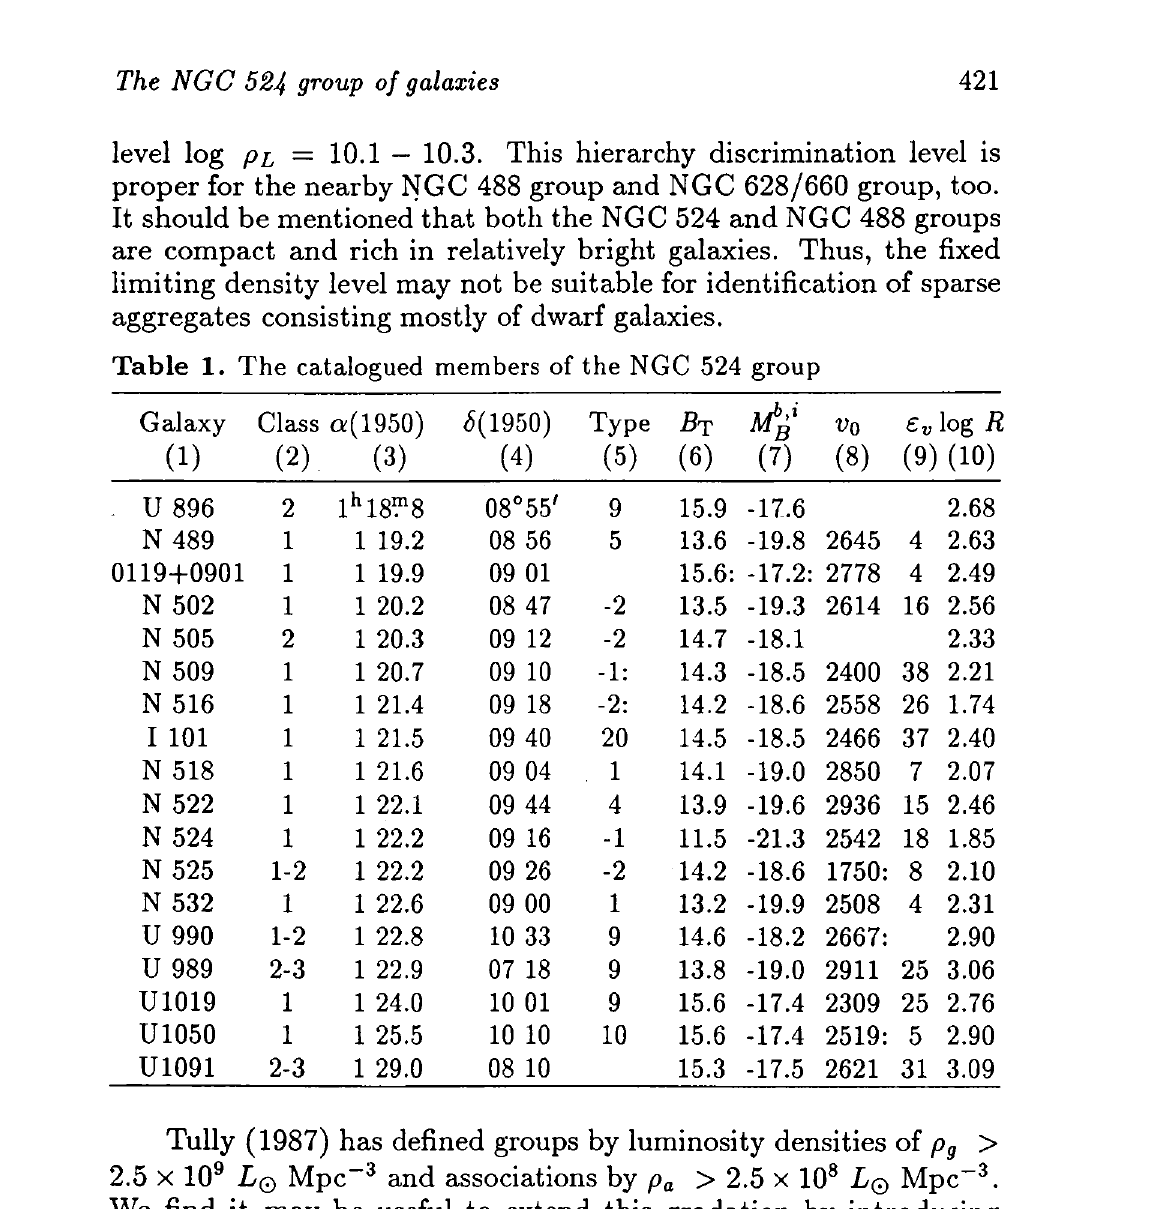
Table 1. The catalogued members of the NGC 524